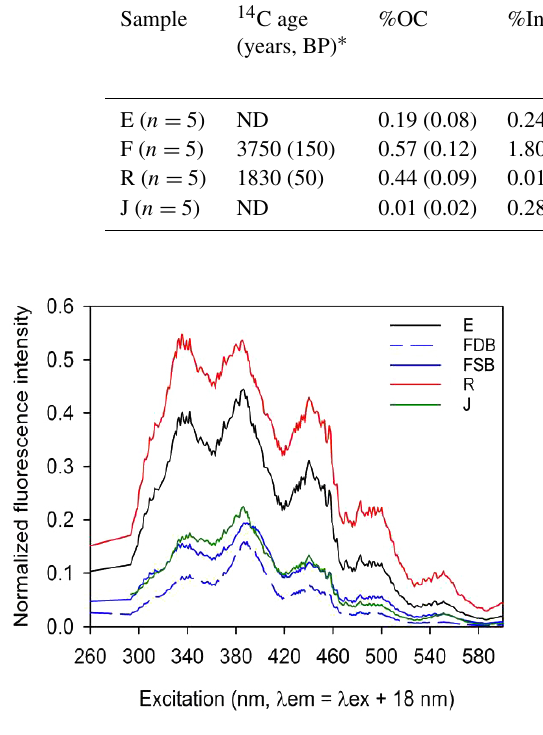
Figure 2. Mean normalized synchronous fluorescence spectra for basal ice samples. E – Engabreen, F – Finsterwalderbreen, R – Rus- sell Glacier, J – Joyce Glacier, DB – dispersed banded, SB – solid